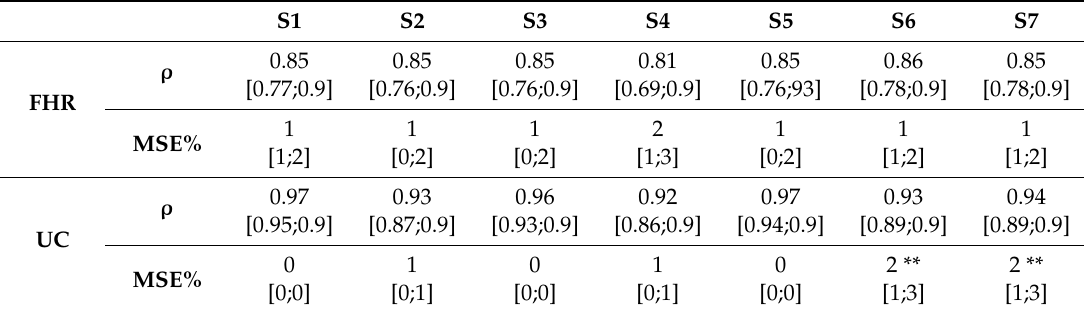
*,**, P-value lower than 0.05 and 0.01, respectively, when comparing signal morphology variables computed from S2–S7 against those computed from